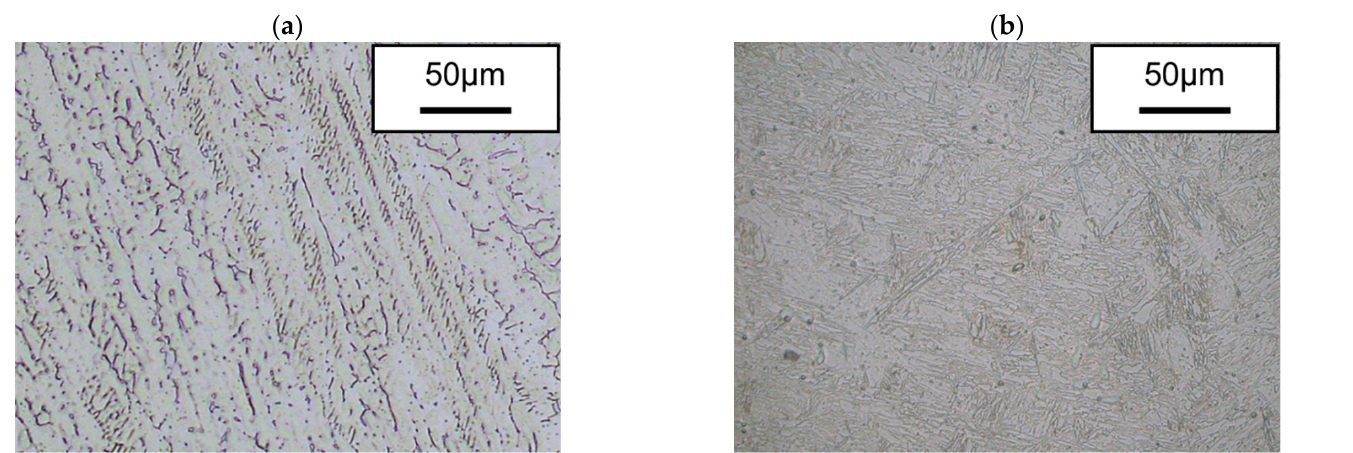
Figure 7. Microstructure of the materials as deposited ( a ) stainless steel SS 316L and ( b ) steel ER70.